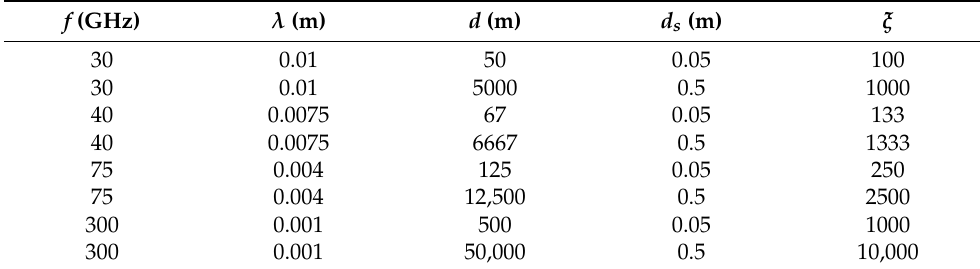
Table 5. Recommendations in inter-satellite communication.